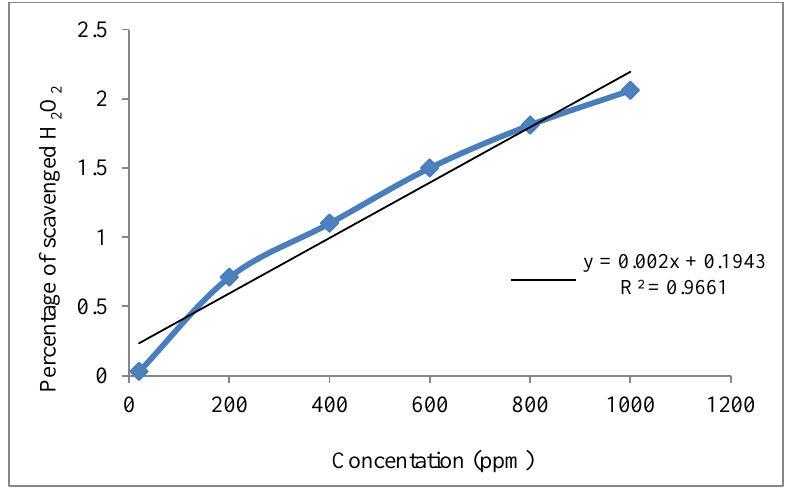
Figure 7. H 2 O 2 Scavenging activity of C 1